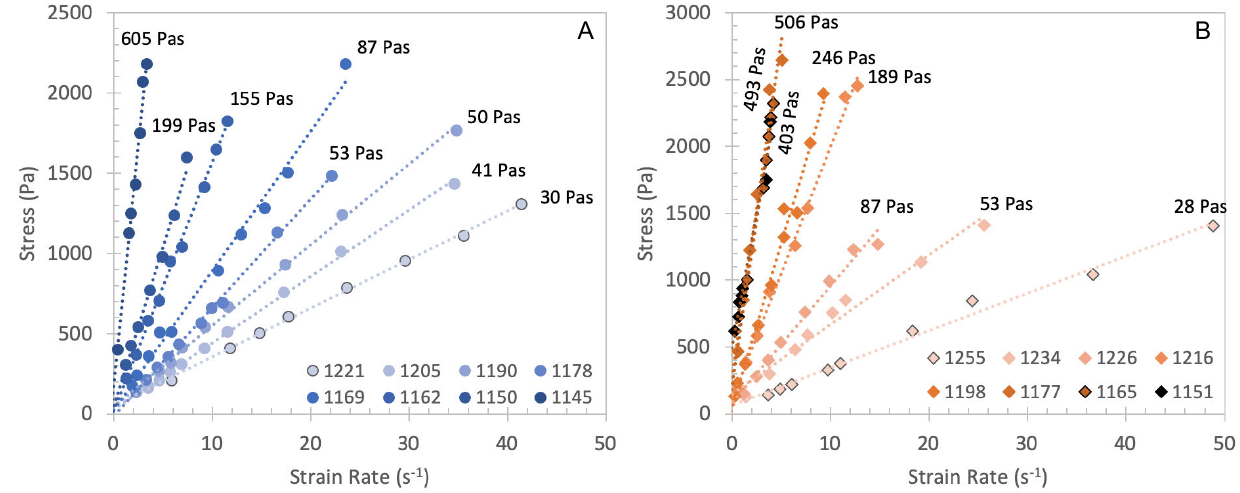
Figure 7: Flow curves of each isothermal, subliquidus experiment plotted for [A] Nyiragongo and [B] Nyamura- gira. Bingham fits were calculated using the equation σ = σ y + η ˙ γ with viscosity listed for each experiment. Fit quality and other parameters are listed in Table 2.